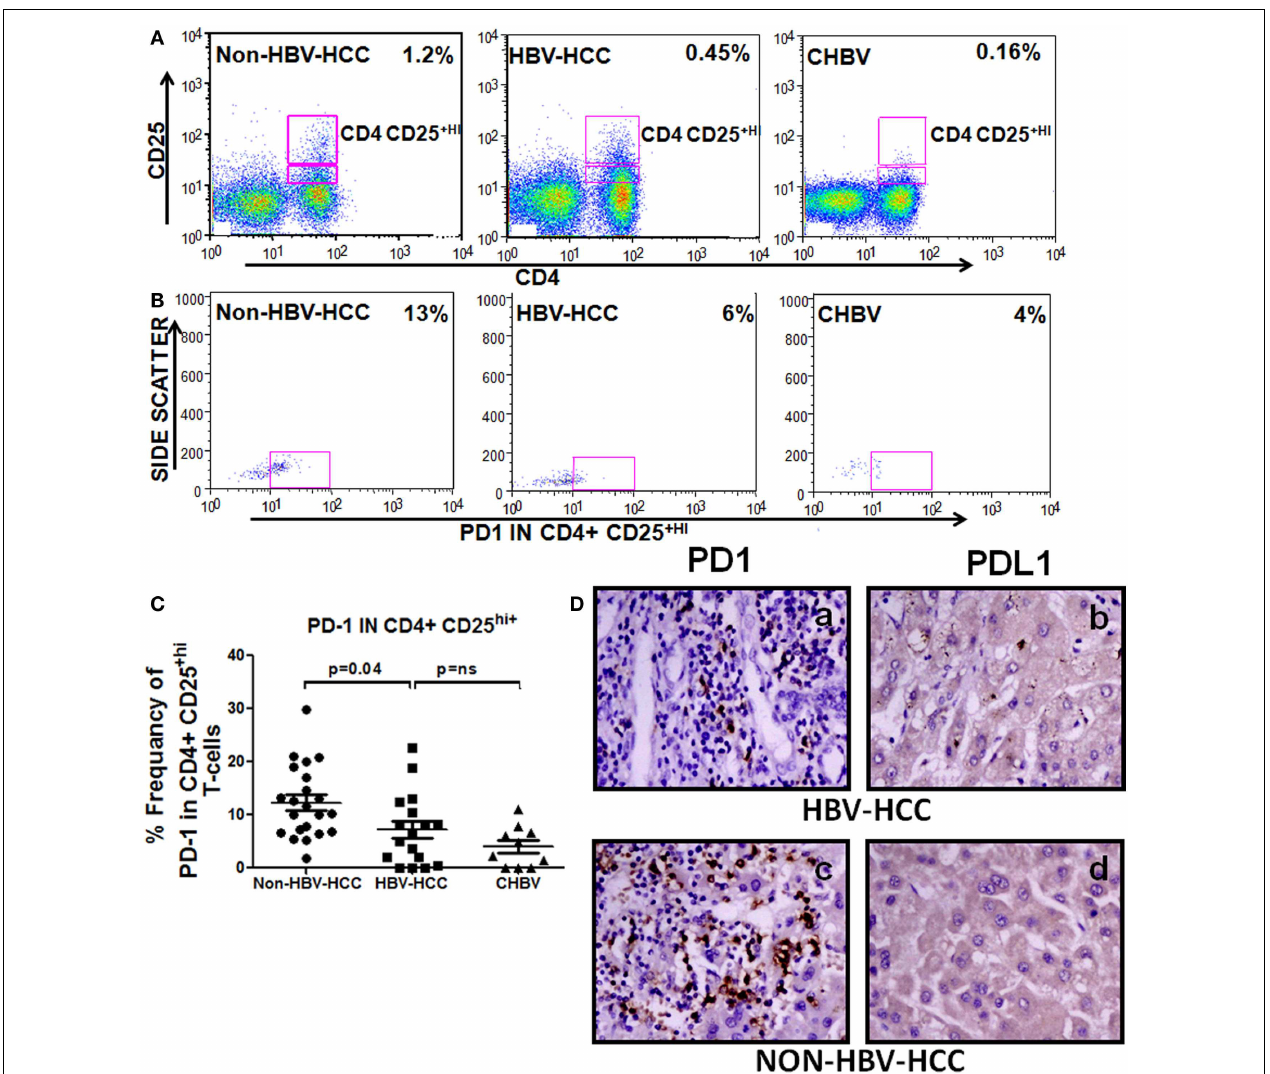
FIGURE 6 | (A–C) Representative flow-cytometric dot plots and scatter plot showing increased expression of PD1 on CD4 + CD25 + Tregs of non-HBV-HCC patients than HBV-HCC patients. (D) Immunohistochemistry on paraffin-embedded sections confirming the increased expression of PD1 and PDL1 (c,d) in non-HBV-HCC than HBV-HCC (a,b) patients. Magnification: 40 ×